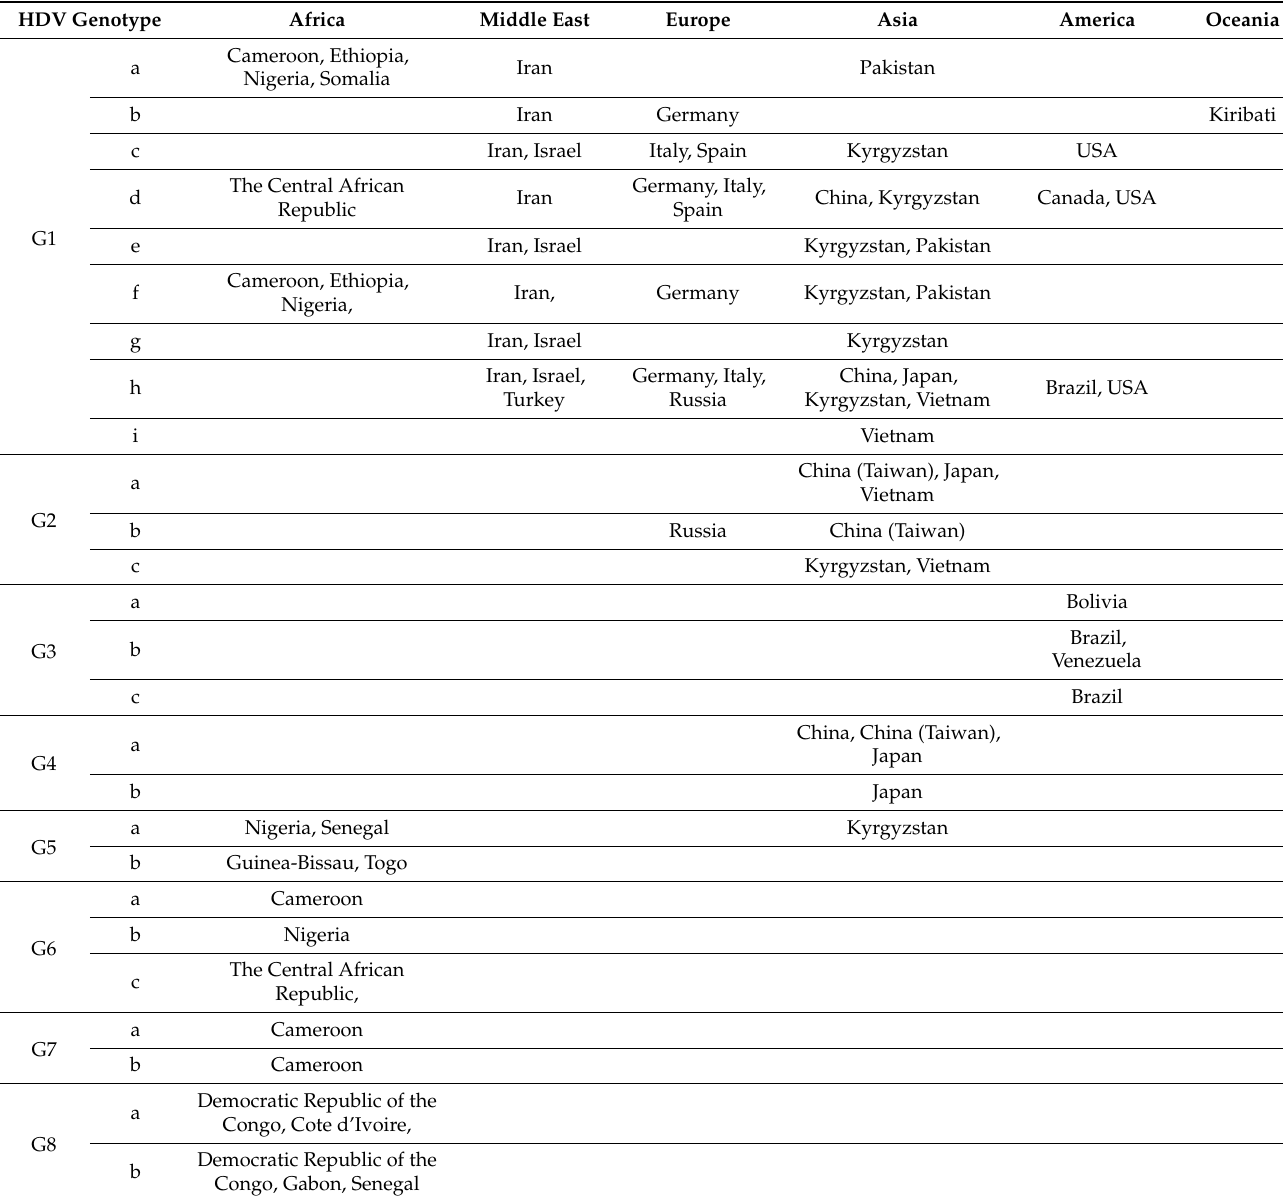
Table 1. Geographic distribution of HDV genotypes and